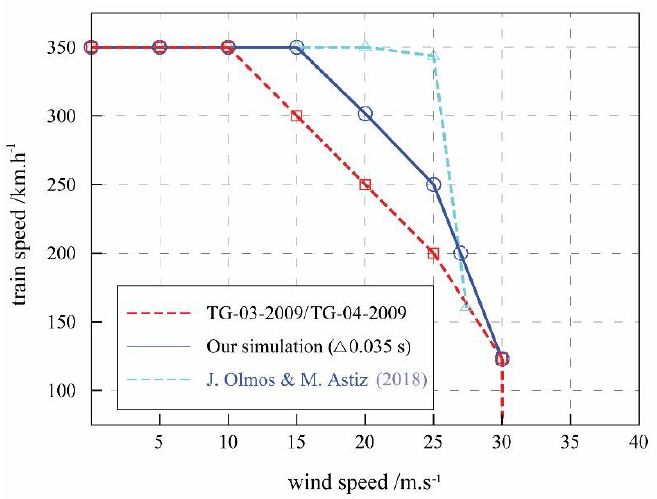
Figure 24. Safety domain when high-speed train enters tunnel from crosswind.